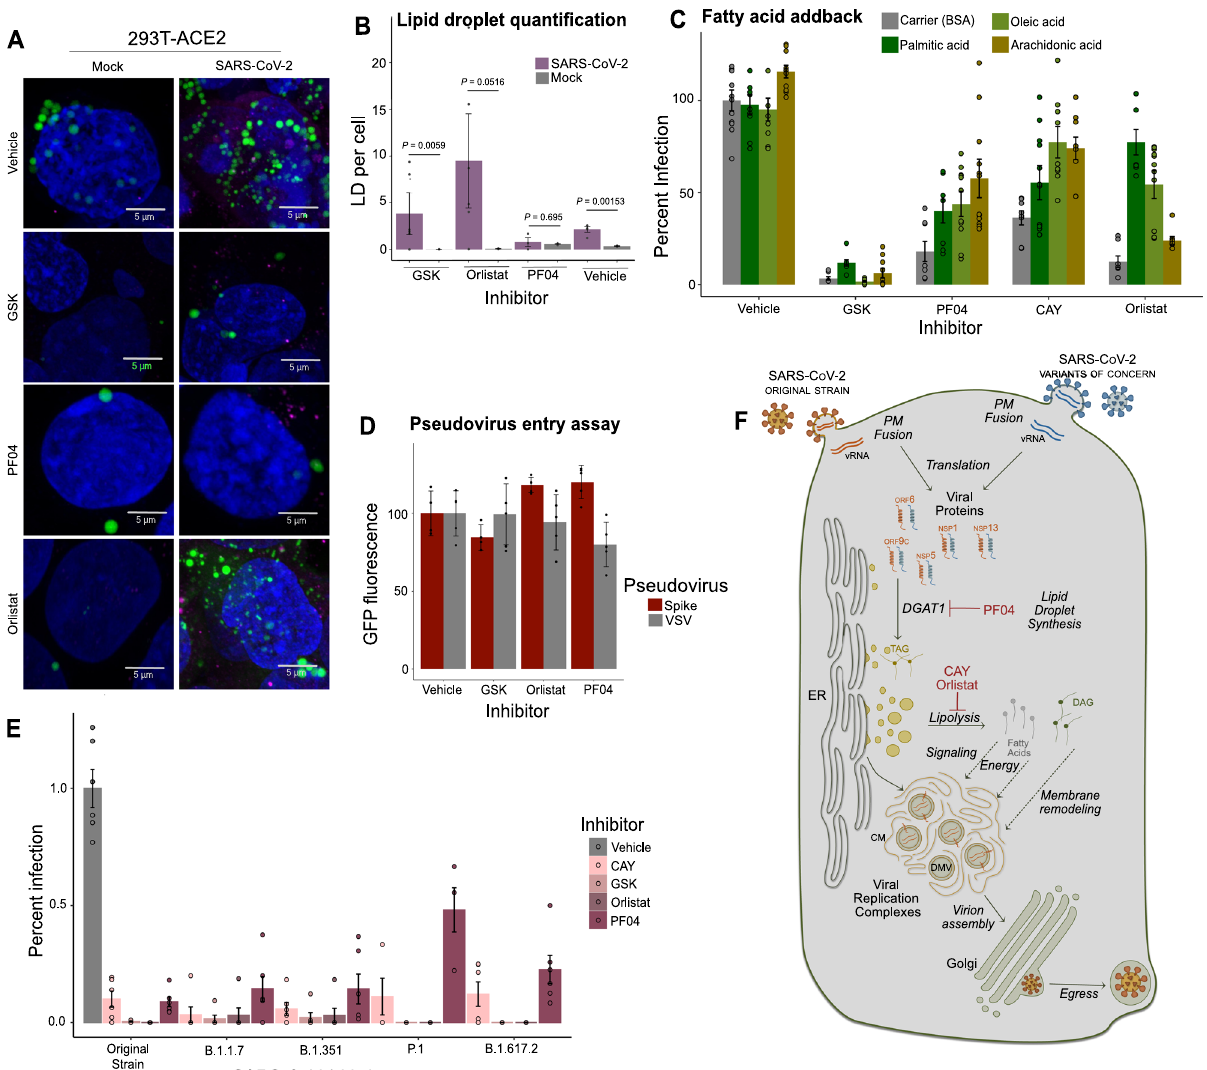
Fig. 6 Mechanisms and breadth of glycerolipid inhibition against SARS-CoV-2. A Representative images of HEK293T-ACE2 cells treated with each indicated inhibitor (10 µ M) or vehicle (DMSO), infected with SARS-CoV-2 for 48 h (MOI = 1), and stained to visualize lipid droplets (BODIPY 493/503), and dsRNA. Images are representative of three independent experiments. B Quanti fi cation of lipid droplet numbers in ( A ). Data are mean ± SE for n = 6 biological replicates; P -values are derived from one-way ANOVA. C Partial rescue of inhibition of viral replication by supplementation with exogenous fatty acids. Inhibitors and fatty acids are both used at 10 µ M, administered simultaneously overnight before a 48 h infection (MOI = 0.1). Data are mean ± SE for n = 10 biological replicates, from three independent experiments. D GFP fl uorescence resulting from an infection with lentivirus pseudotyped with either SARS-CoV-2 Spike protein or VSV G protein. Data are mean ± SD for n = 5 biological replicates. E Inhibition of the original strain and four variants of concern of SARS-CoV-2 in 293T-ACE2 cells by four inhibitors of glycerolipid biosynthesis, each at 10 µ M overnight prior to an 48-h infection (MOI = 0.1). Data are from three independent experiments; data are mean ± SE for n = 6 biological replicates. F A model for neutral lipid fl ux during SARS-CoV-2 infection. vRNA viral RNA; PM plasma membrane; DGAT1 diacylglycerolacetyltransferase 1; TAG triacylglycerol; DAG diacylglycerol; ER endoplasmic reticulum; CM convoluted membrane; DMV double-membraned vesicle Source data are provided as a Source Data fi